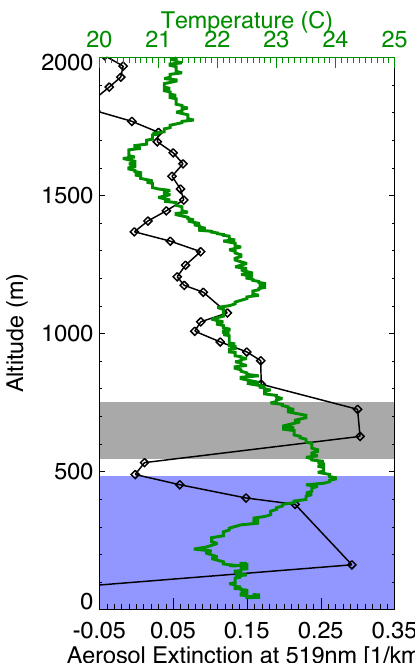
Fig. 3. The aerosol optical depth and temperature during the down- ward spiral northwest of our scene are presented in this figure. Opti- cal depth observations were made by the AATS-14 instrument, and the derivative with respect to height (equivalent to the extinction coefficient) of observations at 0.519µm is presented in black. Two layers of aerosols are present. The lowest, between about 150 and 350m, was most likely not observable in our scene. The upper layer, between 550 and 750m, was probably above the cloud and therefore the same AAC that we observed in our scene. The atmospheric tem- perature profile is shown in green. At 48m, there is a sharp change in the temperature profile. This probably marks the upper bound- ary of the marine stratocumulus cloud that existed at this location several hours before. Based on this information, we constructed our radiative transfer model so that the cloud top is at 480m, with an aerosol layer above between 550 and 750m. The initial aerosol op- tical thickness value of the upper layer was estimated to be 0.16 at 0.555µm from AATS-14 data.